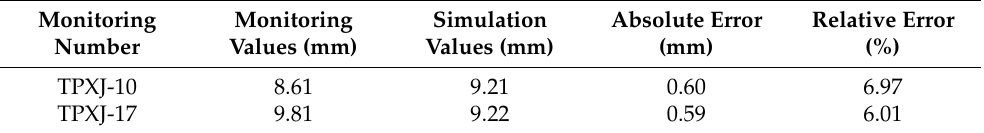
Table 5. Comparison of simulation results and field monitoring data for stage II of water impoundment.